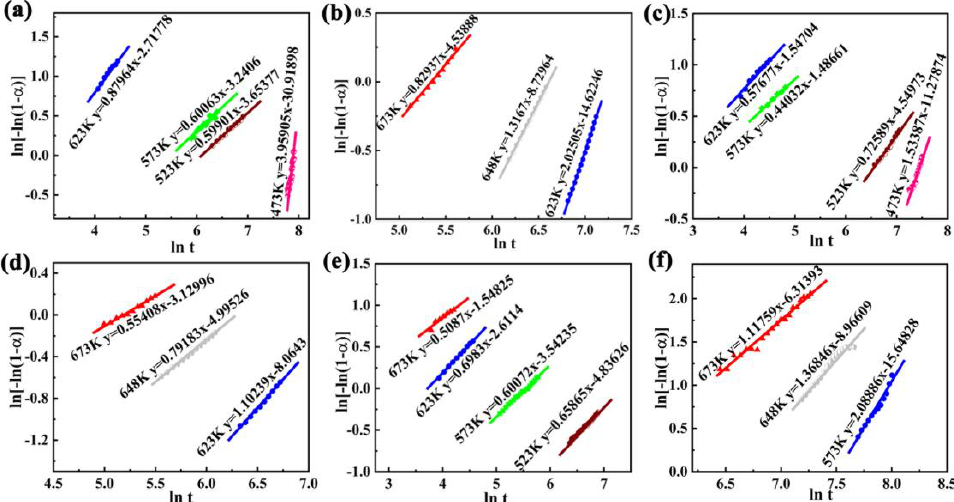
Figure 5. The ln [ln(1 − α )] vs. lnt plots for hydrogenated and dehydrogenated of MgH 2 -2.5 wt% ZnO ( a , b ); MgH 2 -5.0 wt% ZnO ( c , d ); and MgH 2 -7.5 wt% ZnO ( e , f ) Table 1. The hydrogenation of the ln [-ln(1-α)] vs. lnt equation, the standard deviation and activation